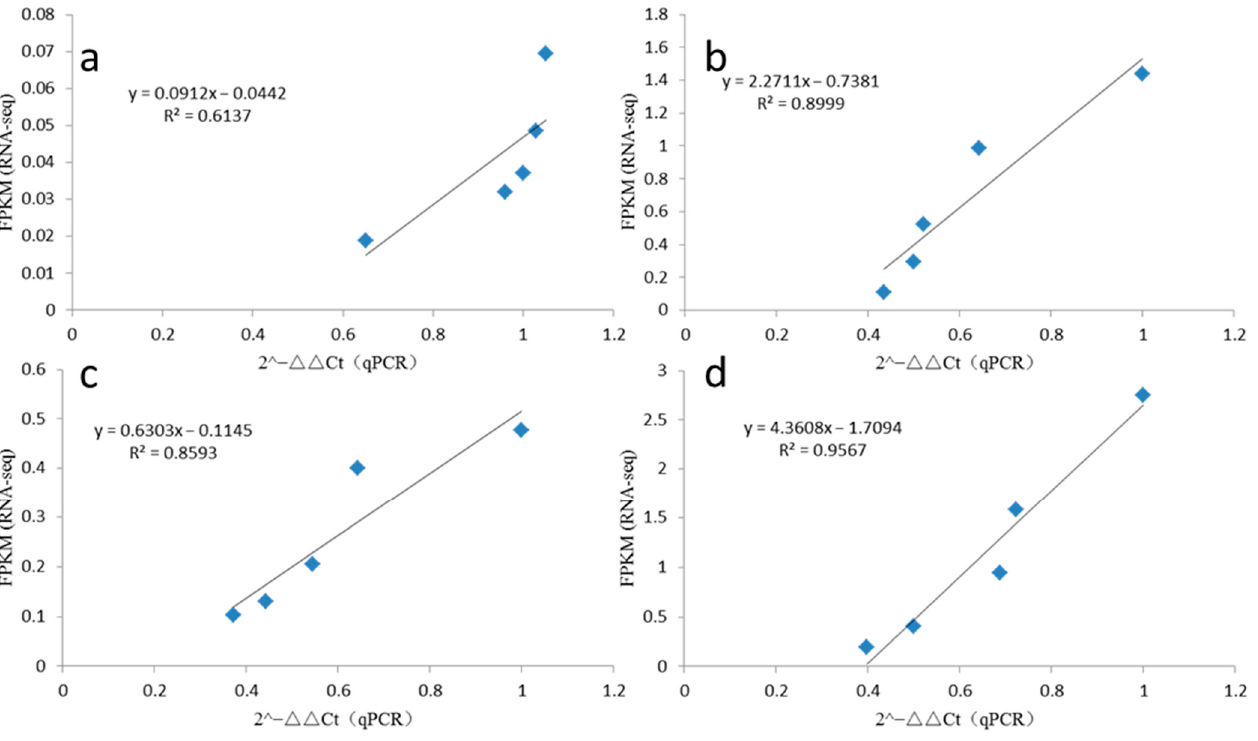
Figure 6. The linear relationship between RNA-seq and qRT-PCR data (( a – d ) were MSTRG.121641.28, MSTRG.121641.3, MSTRG.121644.1, and MSTRG.10845.1,